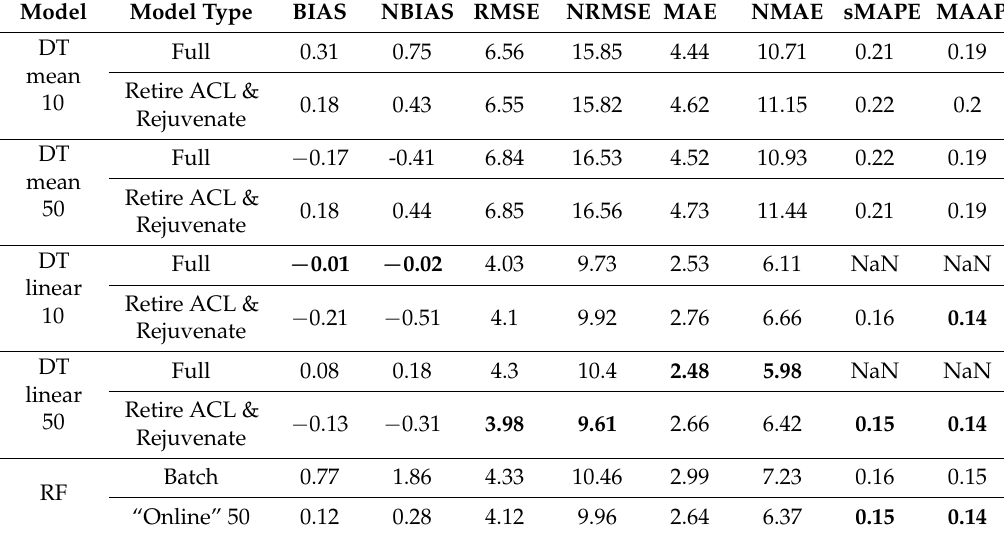
Table 7. One-hour ahead forecasting error evaluation for the different models used in our final comparison. BIAS, RMSE and MAE are in the same units as the electricity price (c € /kWh); NBIAS, NRMSE, NMAE, sMAPE and MAAPE are in